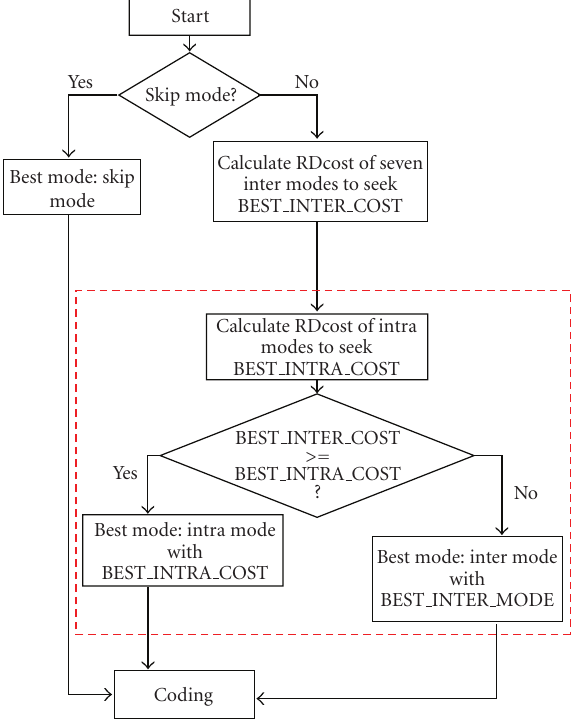
Figure 1: Flowchart of inter-frame